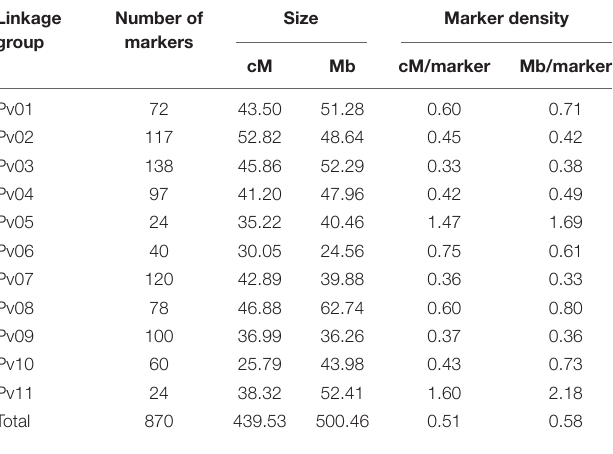
TABLE 2 | Linkage map information for the 242